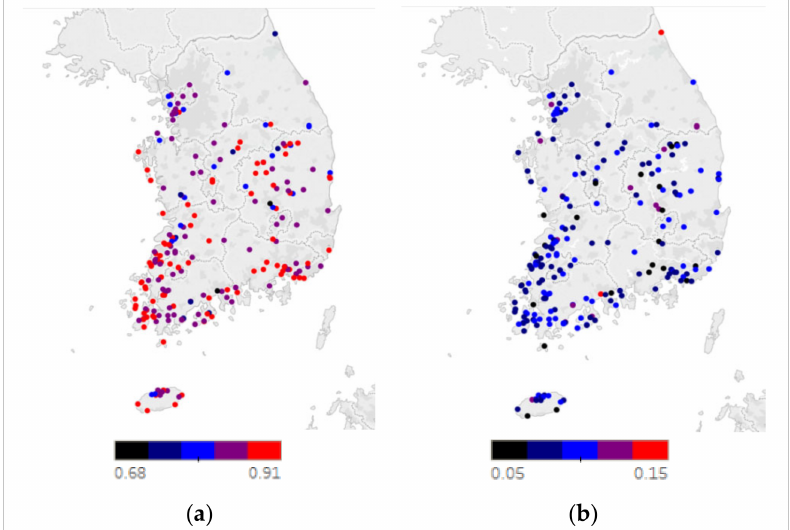
Figure 5. Distribution of the Gompertz model fitness measures: ( a ) coe ffi cient of determination (R 2 ) distribution, and ( b ) normalized root mean square error (nRMSE) distribution.